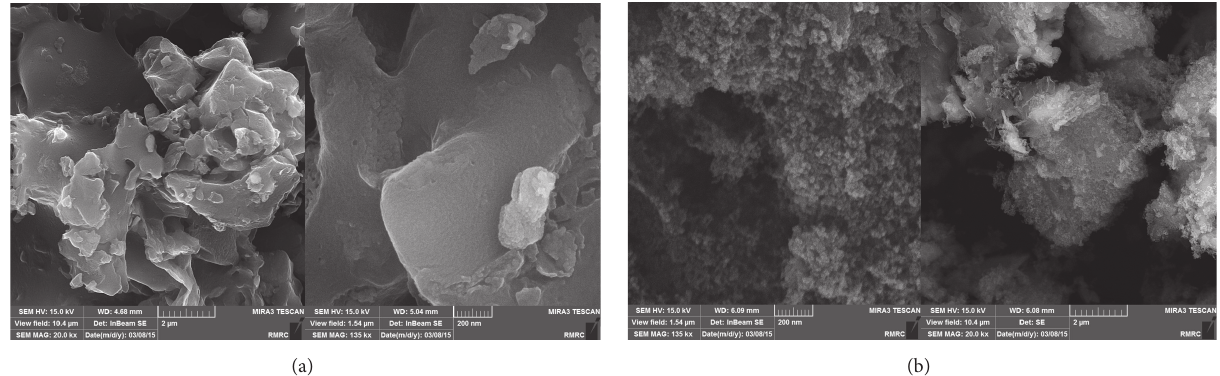
Figure 3: (a) Electron micrograph of the surface of raw GAC. (b) Electron micrograph of the surface of the TiO 2 /GAC composite.